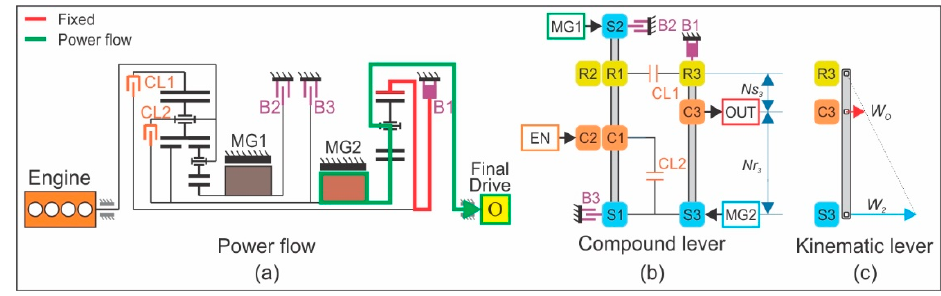
Figure 17. Battery mode.